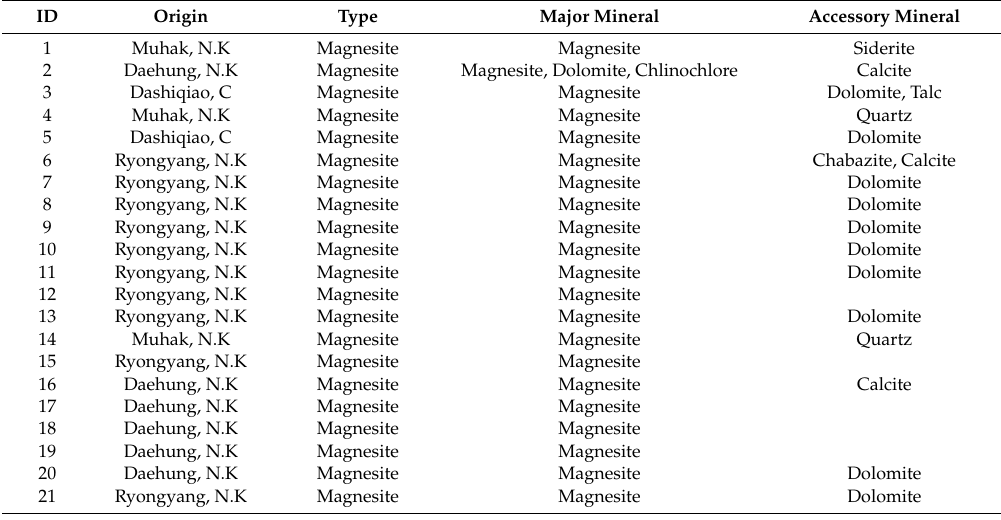
Table 2. The mineral compositions of the samples used in this